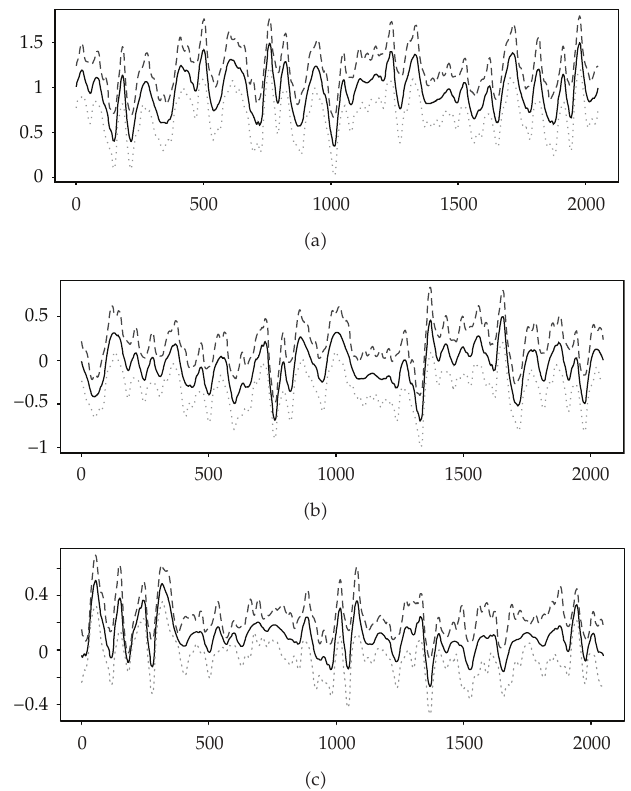
Figure 15: Model M 3 : Bootstrap 95% confidence regions for (cid:5) a (cid:6) δ 1 (cid:5) u (cid:6) , (cid:5) b (cid:6) δ 2 (cid:5) u (cid:6) , (cid:5) c (cid:6) ω 0 (cid:5) u (cid:6) , using linear